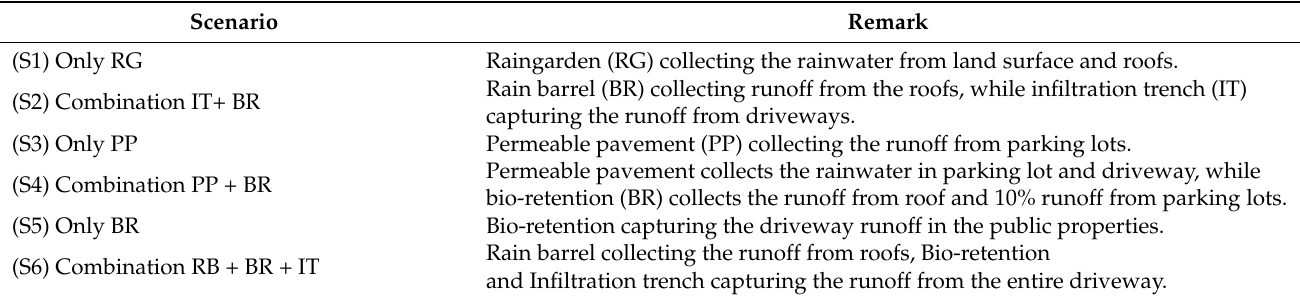
Figure 6. Spatial distribution of LID in part of the City of Renton with existing urban storm system modified after CORMAP 2020. Table 3. Description of the six LID